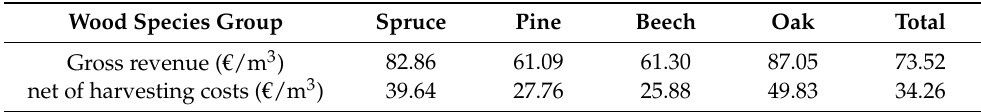
Table 1. Timber revenues by tree species group, weighted by type of ownership and share of self-sourced firewood (reference year =